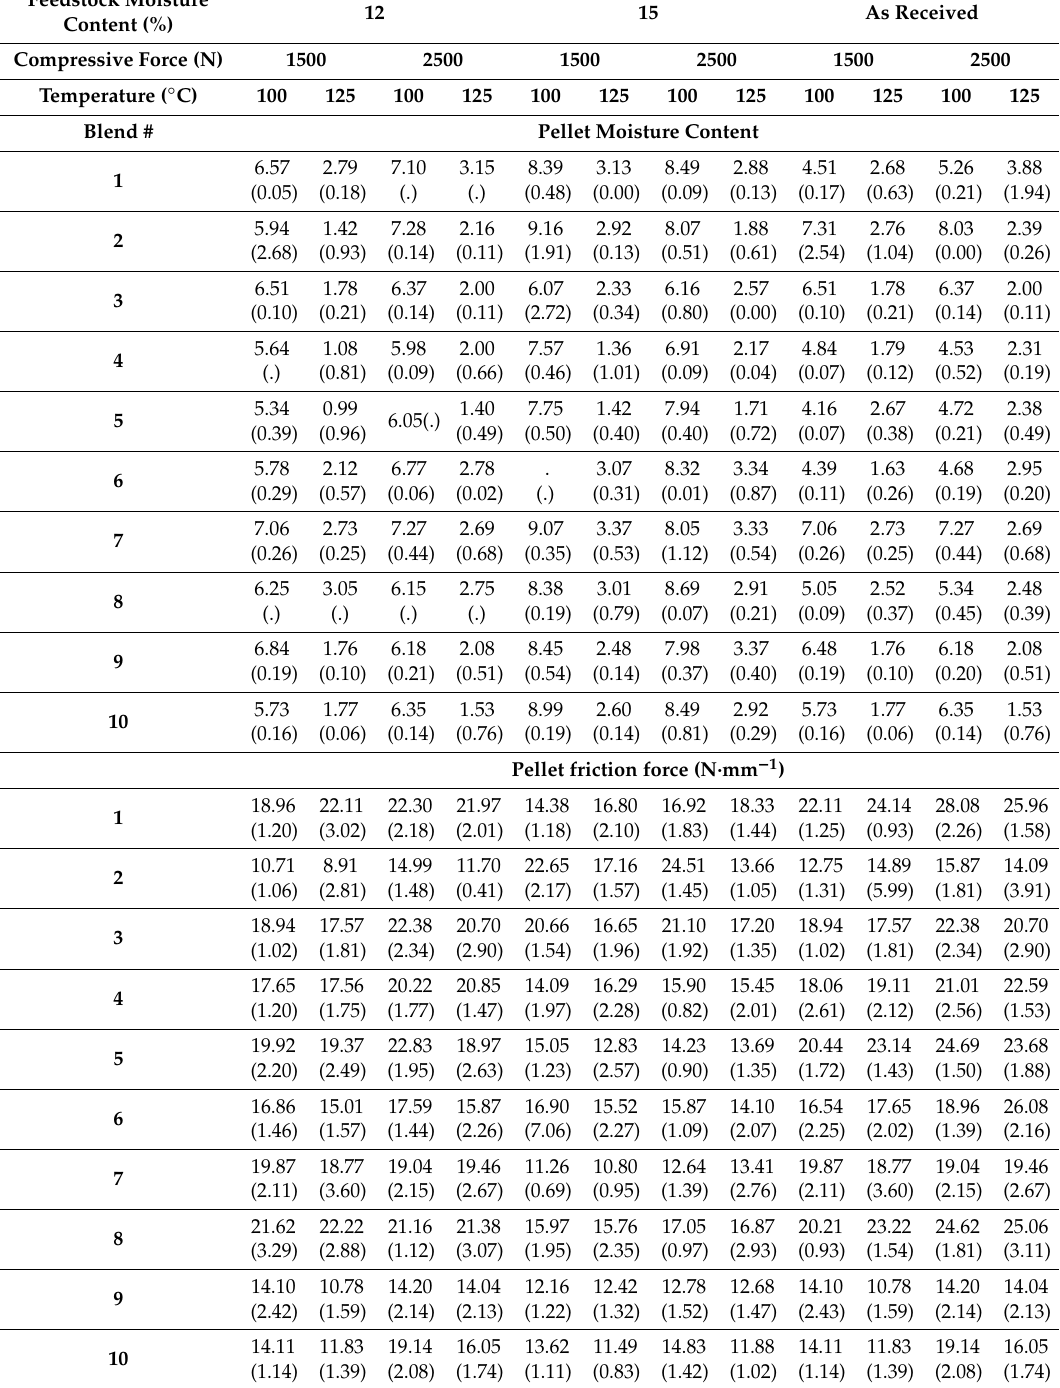
Table A1. E ff ect of combinations of feedstock moisture content, pelletizing compressive force, and temperature on pellet moisture content, friction force, density, and strength. Values are averages (standard deviation) of six